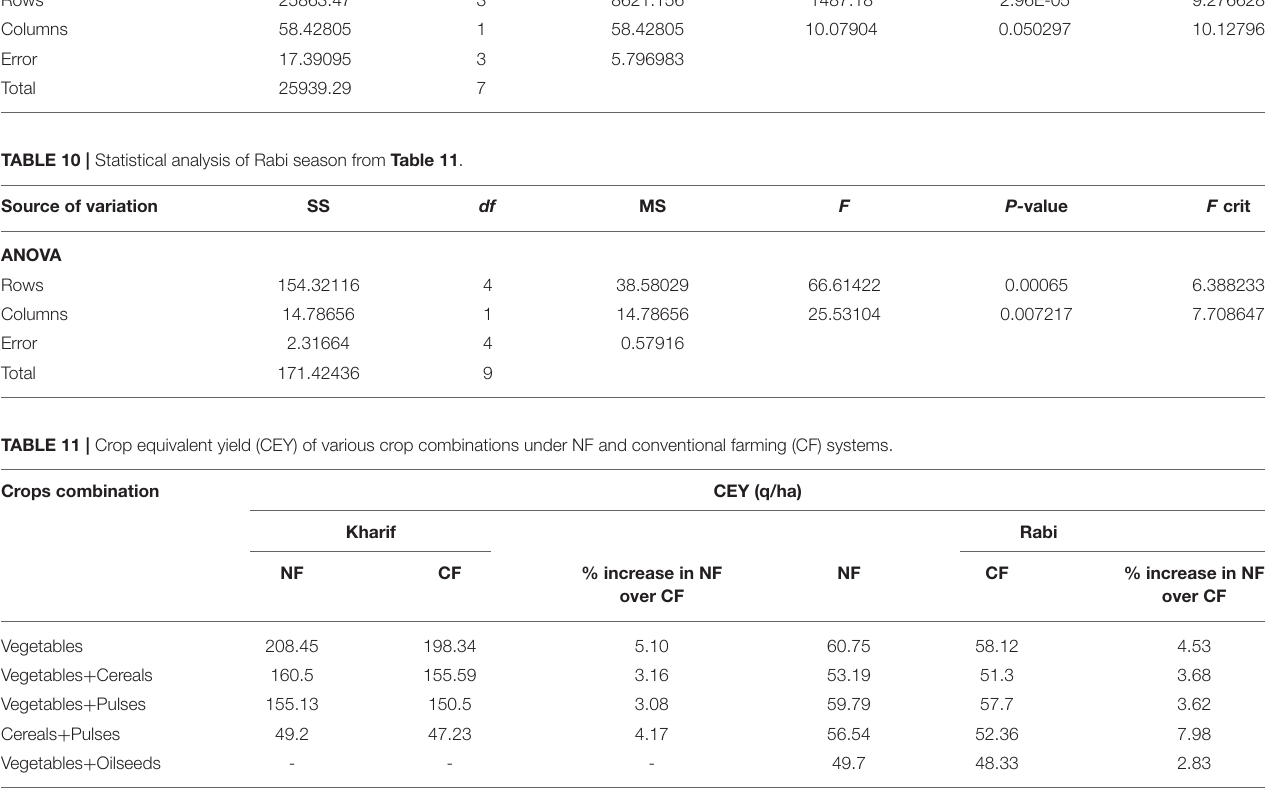
TABLE 12 | Statistical analysis of Kharif season from Table 14 . Source of variation